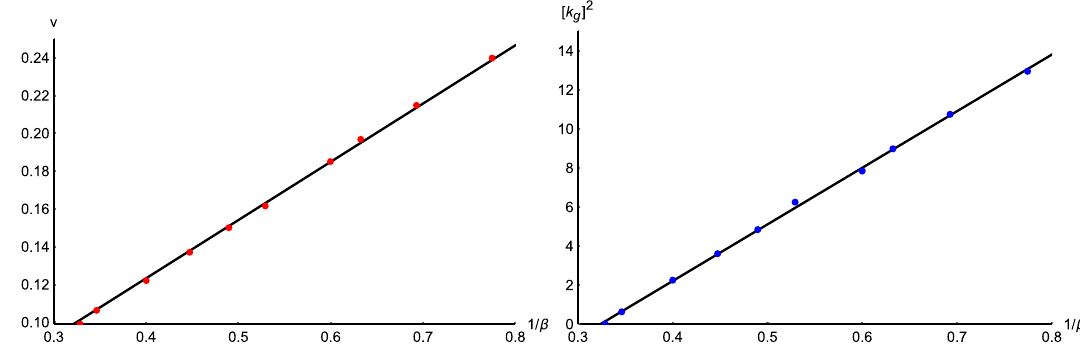
Fig. 6 The scalings of v and k g . Here, we have set T /μ = 0 . 1, α = 1 and J = 0 . 25 and β ∈ [ 0 . 65 , 50